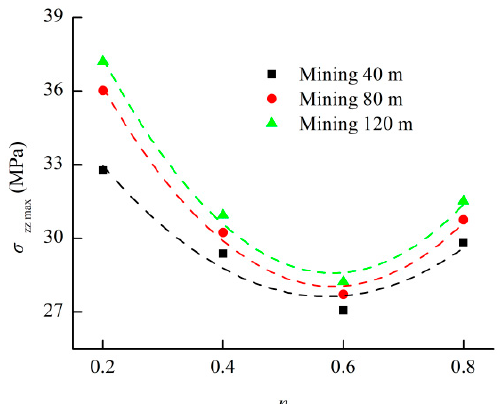
Figure 18. Coupling effect of the cemented rockfill’s granule gradation and mining distance on the maximum internal stress of the backfill.